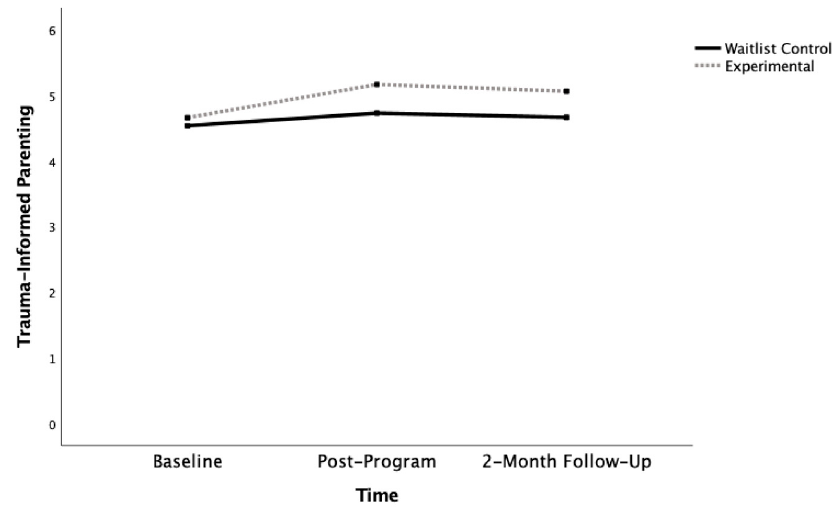
Figure 2. Knowledge and Beliefs in Trauma-Informed Parenting Across Baseline, Post-Program, and 2-Month Follow-Up. Table 1. Descriptive Statistics for Outcome Variables.